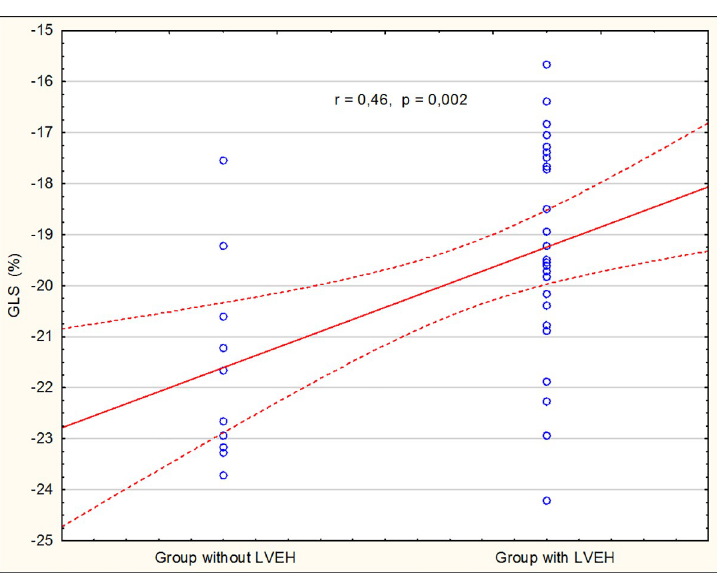
Fig 2. The correlation of GLS with the existence of LVEH. GLS, global longitudinal strain; LVEH, left ventricular eccentric hypertrophy.